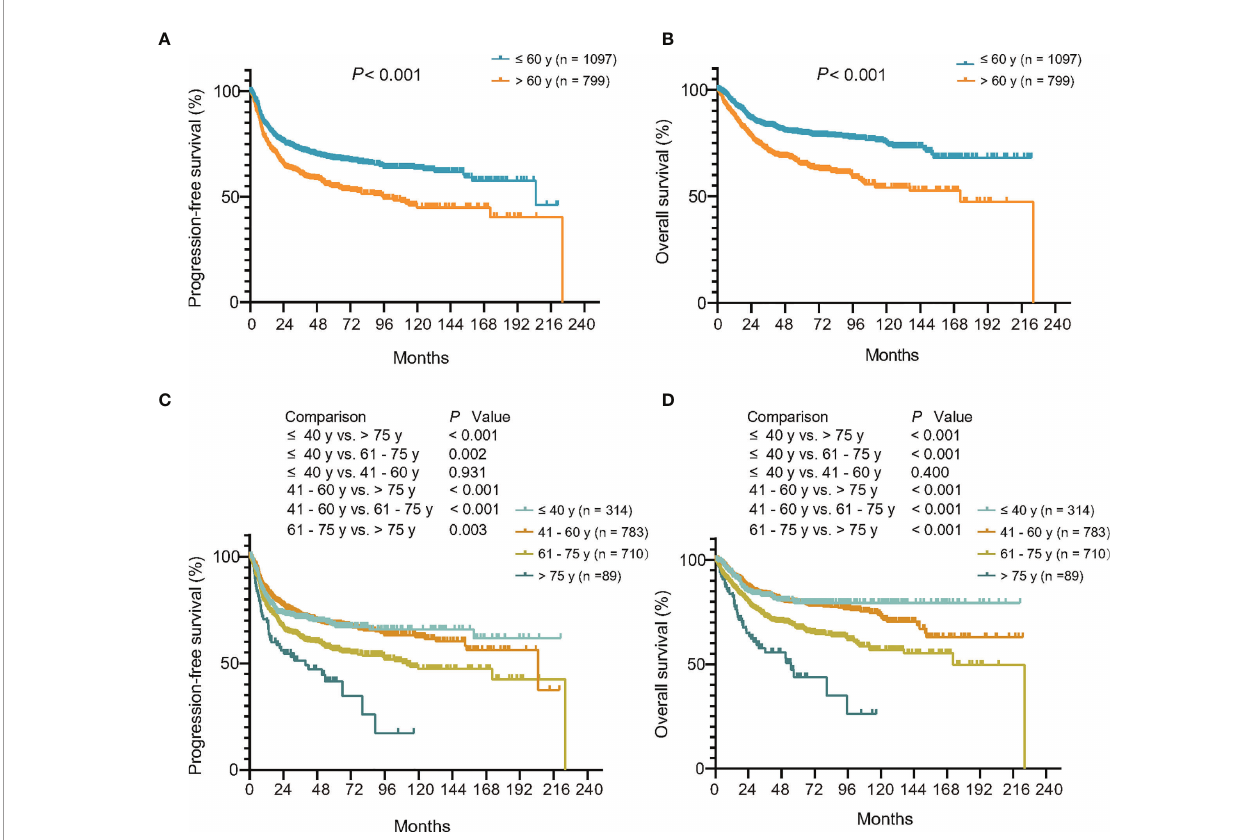
FIGURE 2 | Relationship between age at diagnosis and clinical outcome upon R-CHOP-based immunochemotherapy. (A, B) Kaplan – Meier models of progression- free survival (A) and overall survival (B) according to age at diagnosis of IPI. (C, D) Kaplan – Meier models of progression-free survival (C) and overall survival (D) according to age at diagnosis of NCCN-IPI. R-CHOP, rituximab, cyclophosphamide, doxorubicin, vincristine, and prednisone; IPI, International Prognostic Index; NCCN, National Comprehensive Cancer Network